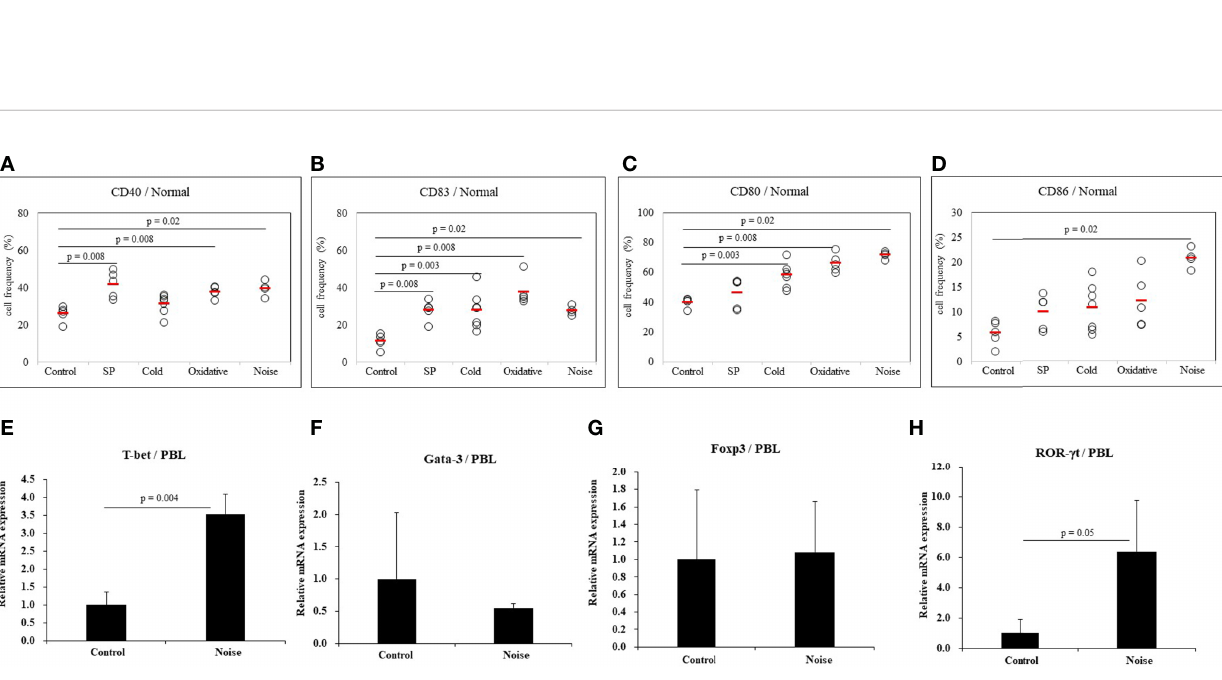
FIGURE 3 | Expression levels of several mRNAs in BD mice by real-time PCR. Expression levels of several mRNAs in peripheral blood leukocytes (PBLs) of BD mice with ocular symptoms were analyzed by real time-PCR (A – D) . Selected genes were Egr2, Ripk2, Rtpn1, and Cebpb. After normalization against b -actin, relative expression levels were analyzed for each sample. The experiment was conducted in duplicate.